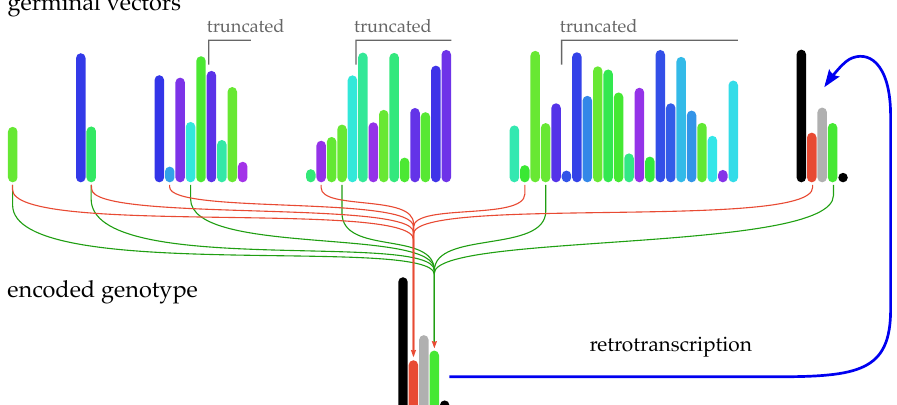
Figure 11. Equivalent germinal vectors representing the midipitch parameter, middle C. As the red and blue arrows show, in this example, only two important values are determining the chosen function